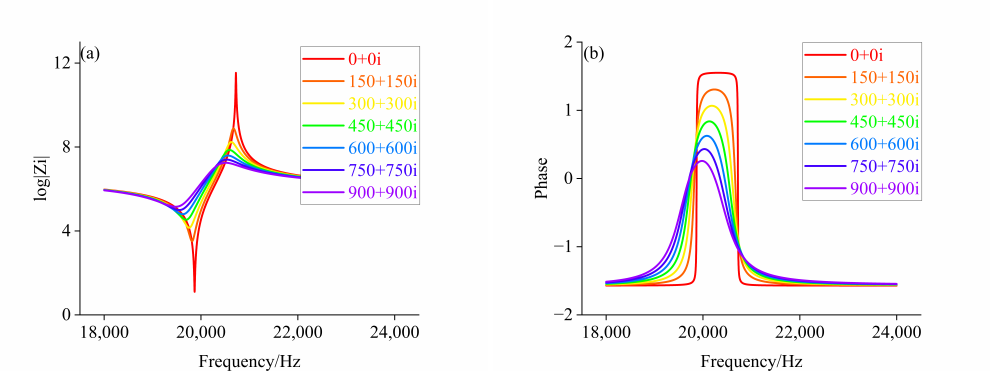
Figure 9. ( a ) Amplitude value characteristics when Z ft is a inductive load; ( b ) Phase frequency characteristics when Z ft is a inductive